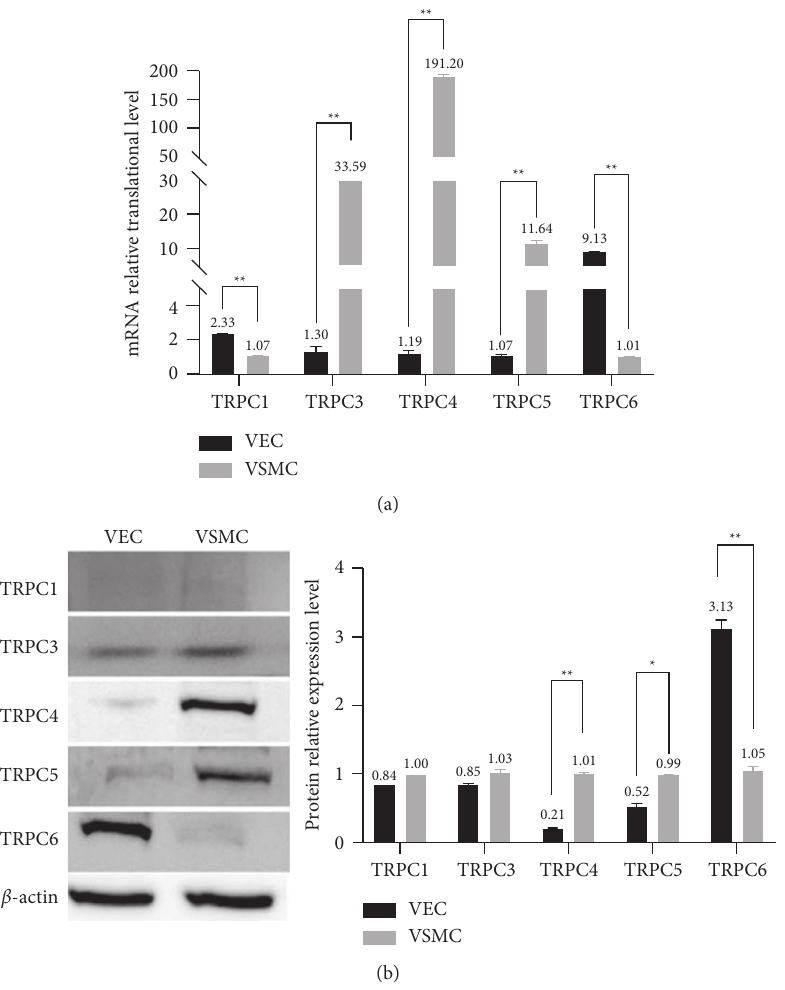
Figure 1: (a) mRNA expression levels of TRPCs (TRPC1, TRPC3, TRPC4, TRPC5, and TRPC6) in VSMCs and VECs measured by RT- qPCR. (b) Western blots and protein expression levels of TRPCs (TRPC1, TRPC3, TRPC4, TRPC5, and TRPC6) in VSMCs and VECs. N � 12. ∗ p < 0 . 05. ∗∗ p < 0 .